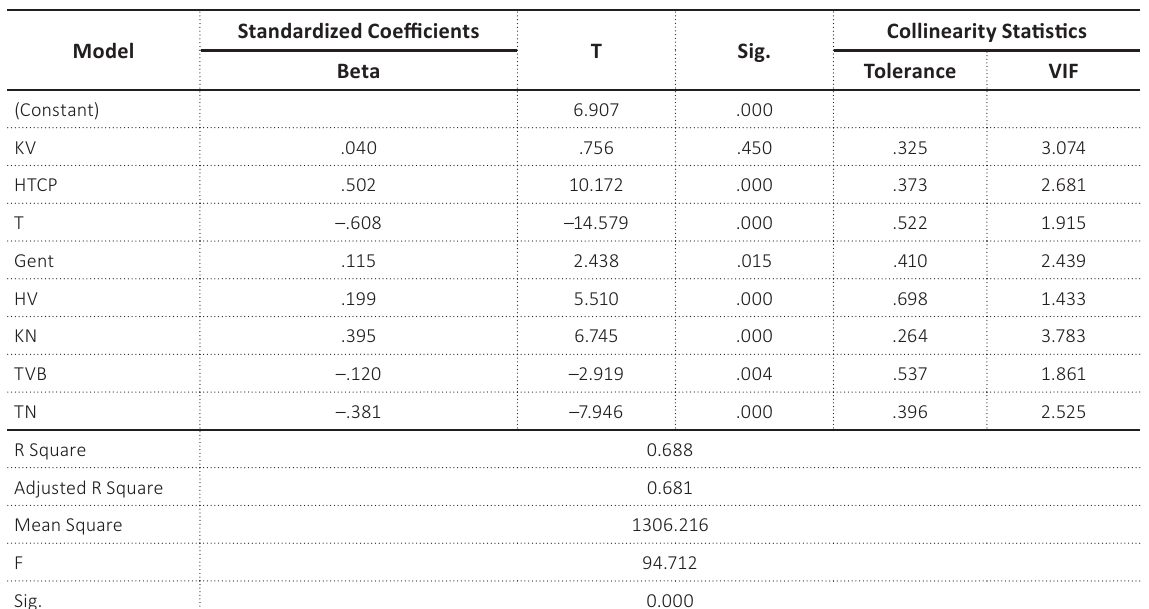
Table 4. Regression model